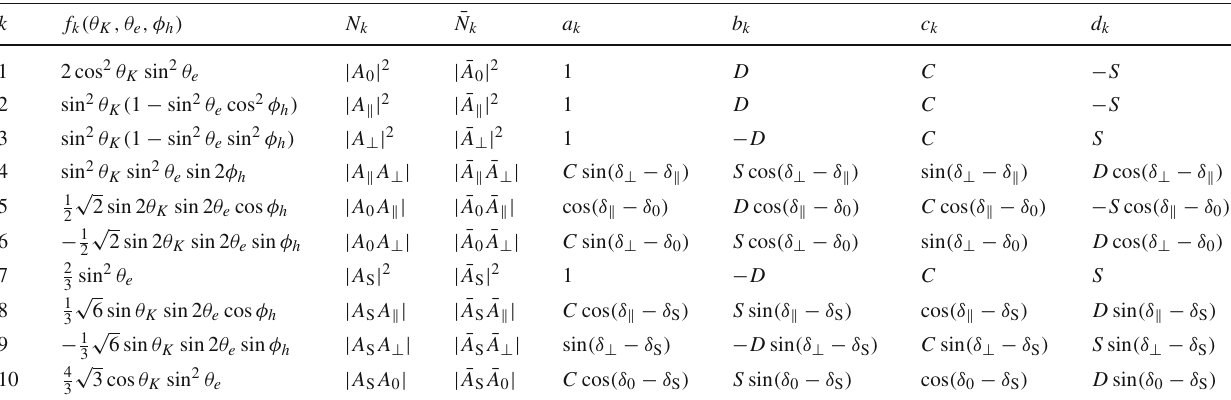
Table 1 Definition of angular and time-dependent functions for B 0 s and B 0 s